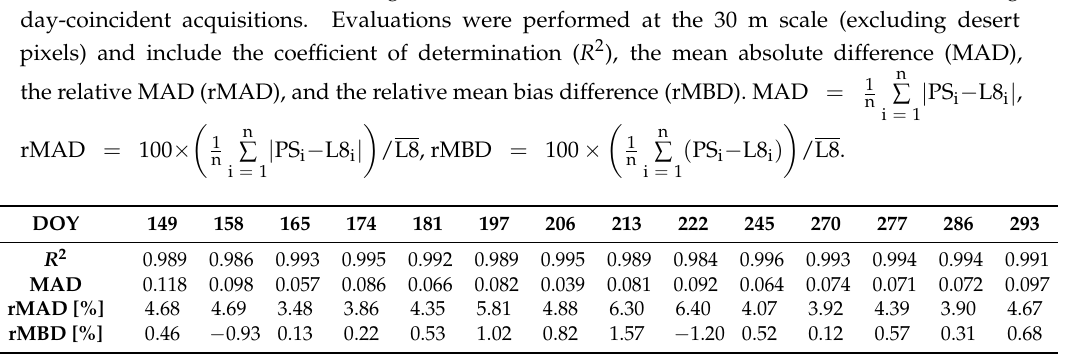
R 2 0.989 0.986 0.993 0.995 0.992 0.989 0.995 0.989 0.984 0.996 0.993 0.994 0.994 0.991